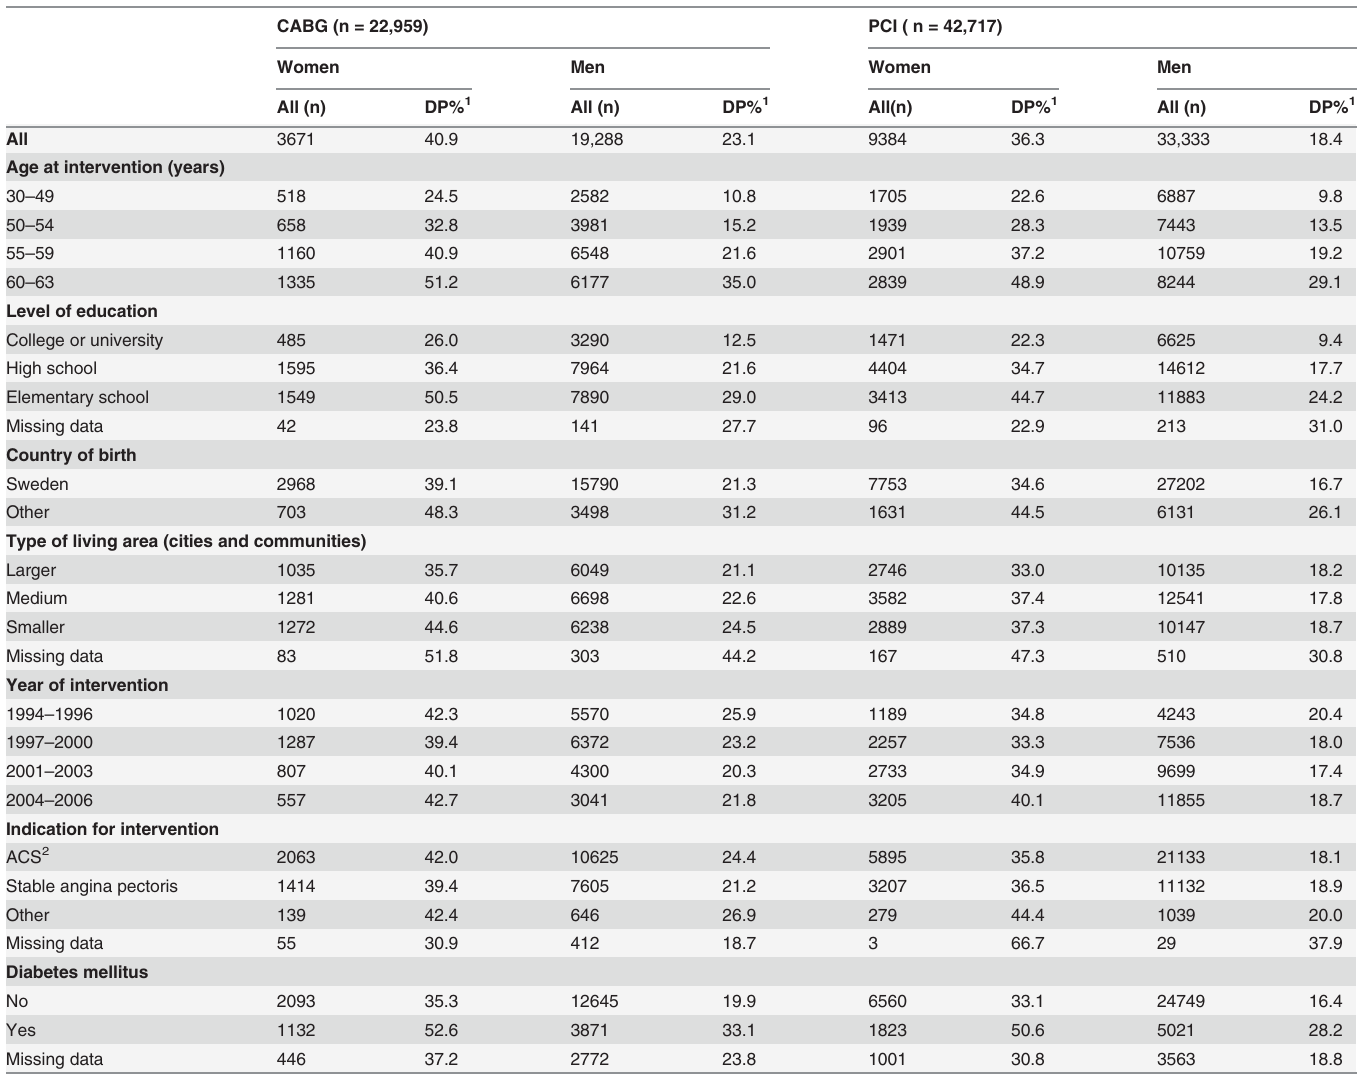
Table 1. Patient characteristics, strati fi ed by type of intervention and gender, of all patients in Sweden (N = 65,676), 30 – 63 years of age, with a fi rst coronary artery bypass graft surgery (CABG) or percutaneous coronary intervention (PCI) within the year 1994 – 2006, and with disability pension (DP) (n = 15,497) at time of